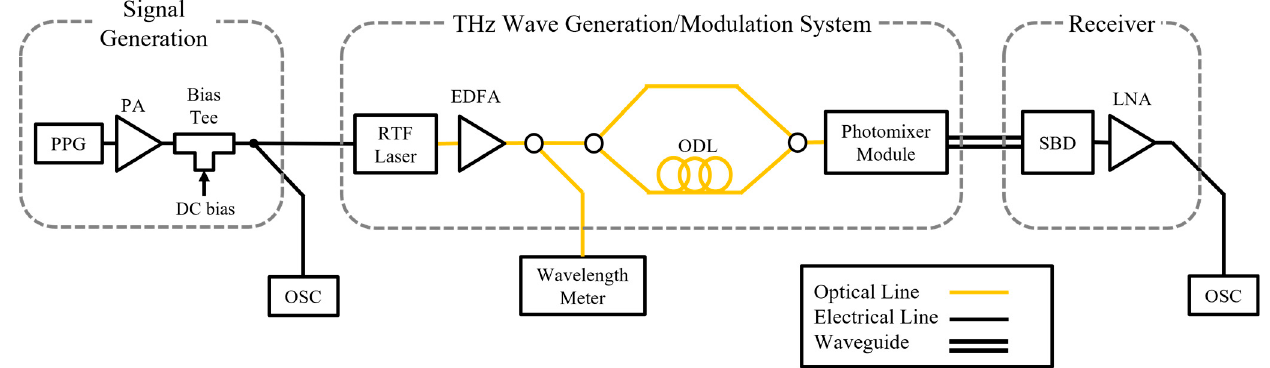
Figure 4. Experimental setup for photomixing using a single RTF laser.